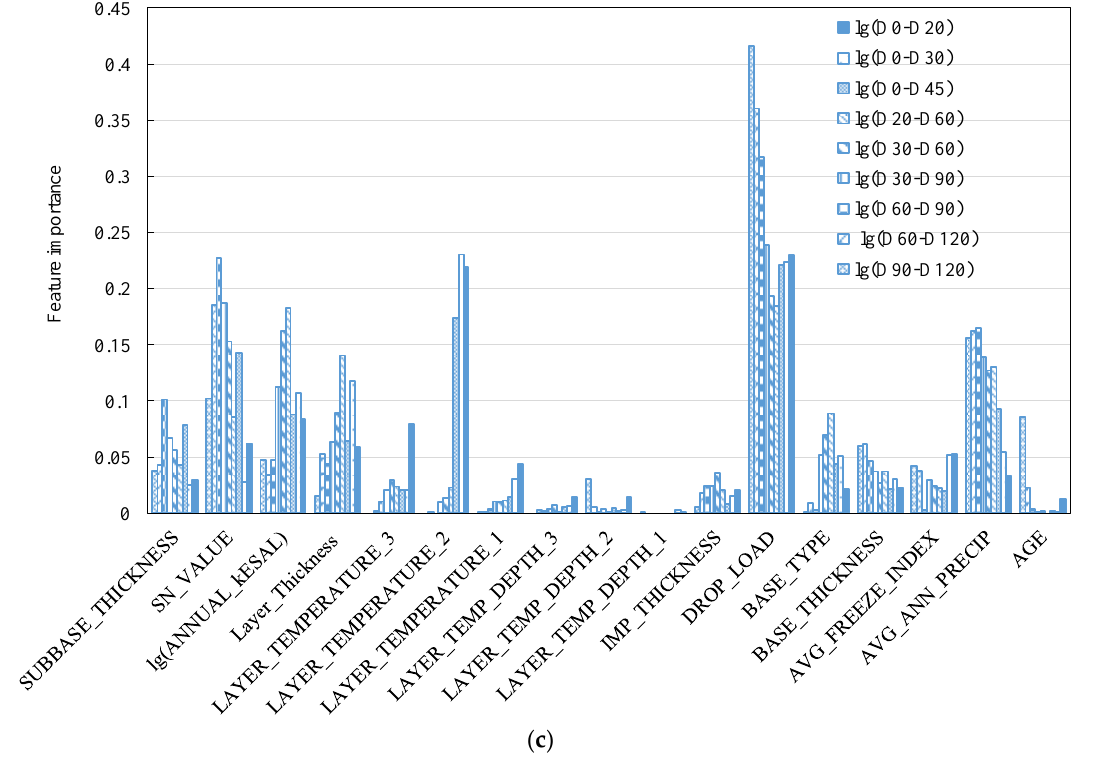
Figure 6. Feature importance of three machine learning methods: ( a ) GBDT; ( b ) RF; ( c ) CART.